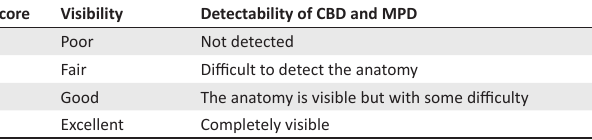
TABLE 2: Visibility and detectability of common bile duct or main pancreatic duct.